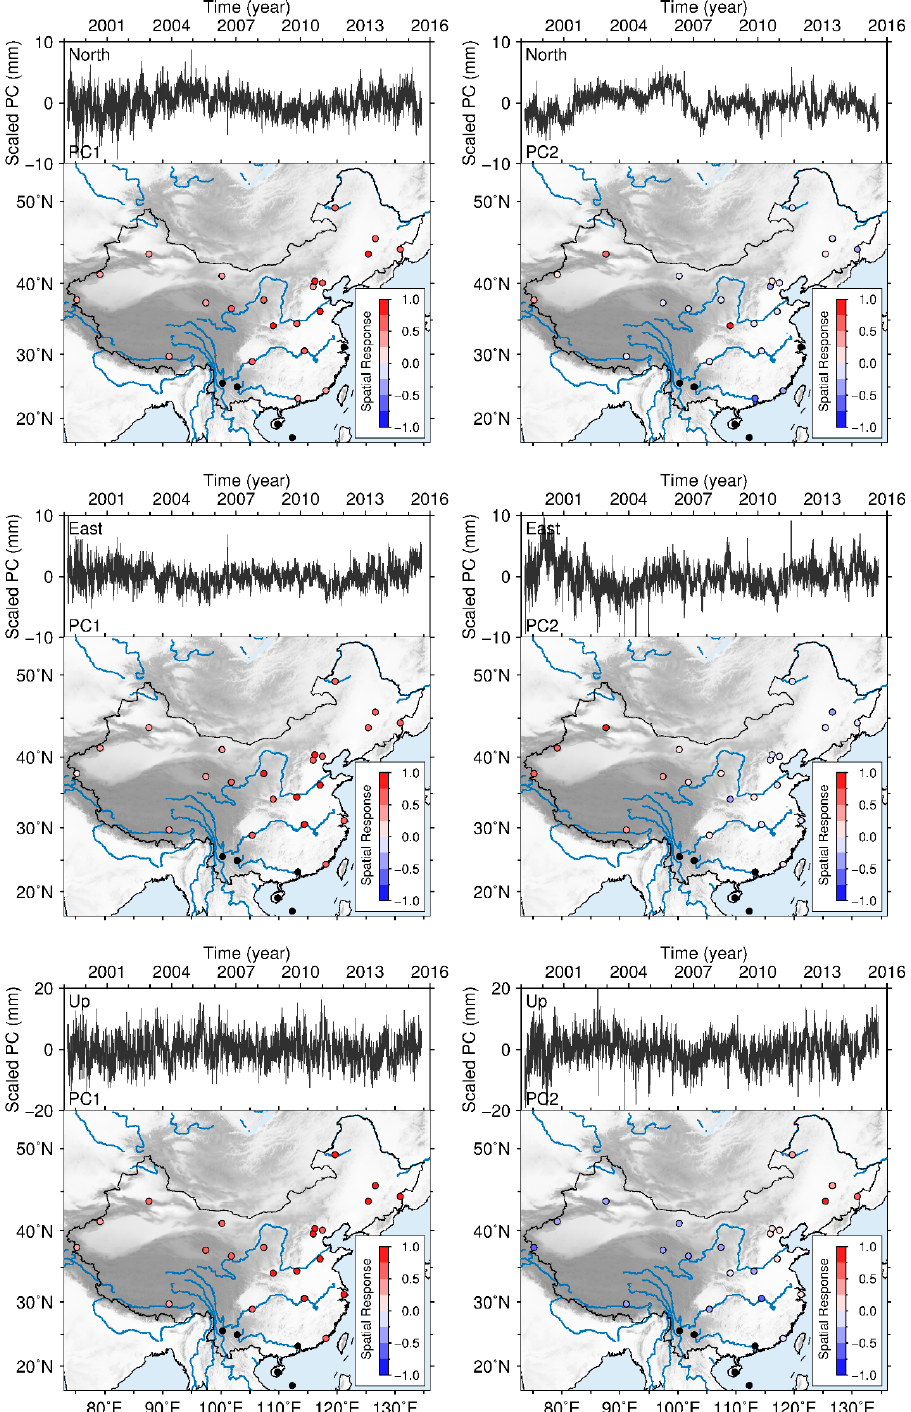
Figure 3. Temporal and spatial responses of the first two PCs for the north ( upper panels ), east ( middle panels ), and up ( lower panels ) components of CMONOC-I. Black dots indicate the excluded stations.